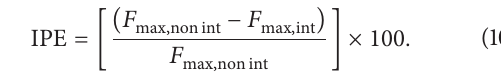
peak error (IPE) percentage associated with neglecting the floor